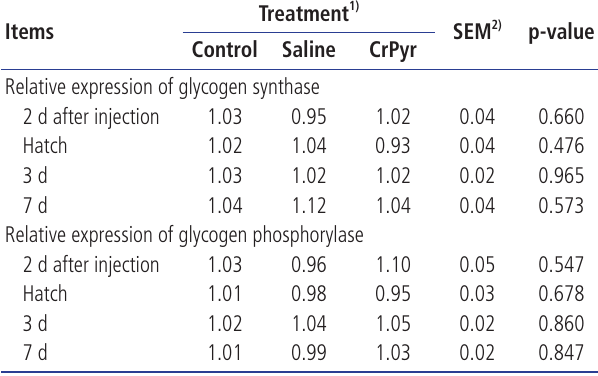
Table 9. Effects of in ovo feeding of creatine pyruvate on the mRNA expressions of glycogen synthase and glycogen phosphorylase in thigh muscle of embryos and broilers on 2 d after injection, the day of hatch, 3, and 7 d post-hatch